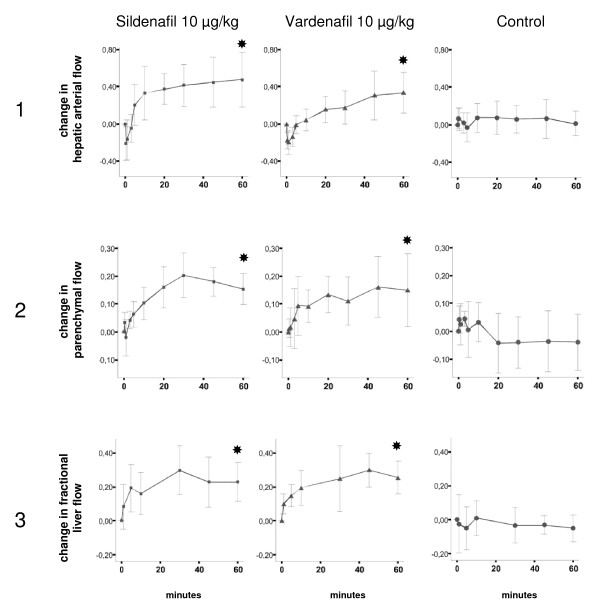
Course of relative changes of hepatic hemodynamic parameters after slow intravenous injection of 10 μg/kg sildenafil or vardenafil or 0.9% NaCl. Ordinate: time (minutes). Abscissa: relative change (e.g. 0.00 means baseline; 0.10 means: increase by 10%; -0.10 means: decrease by 10%). The values are indicated as mean ± 95% confidence intervals. Significant changes at 60 min (p < 0.05; Wilcoxon rank sum test) are marked with black stars. Panel 1: Hepatic arterial flow. Panel 2: Parenchymal flow. Panel 3: Fractional liver flow.